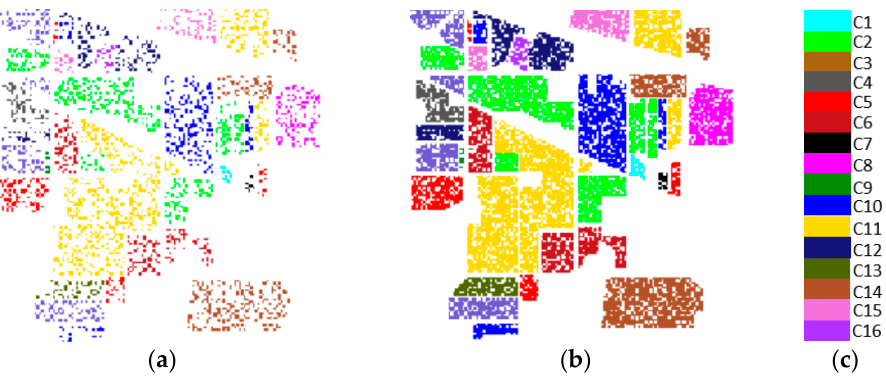
Figure 6. ( a ) Training sample; ( b ) Test sample; ( c ) Tag block.